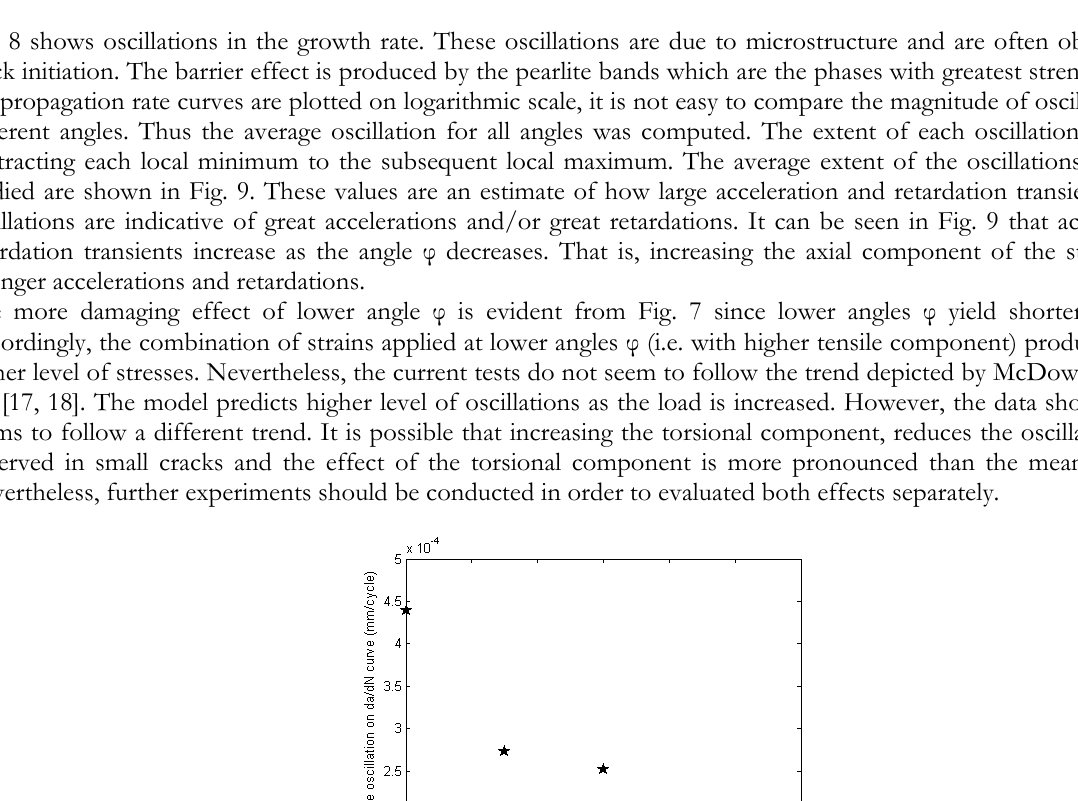
Figure 8: Fatigue crack propagation rates (da/dN) versus crack length for samples a) S1, b) S2, c) S3, d) S4 and e) S5.